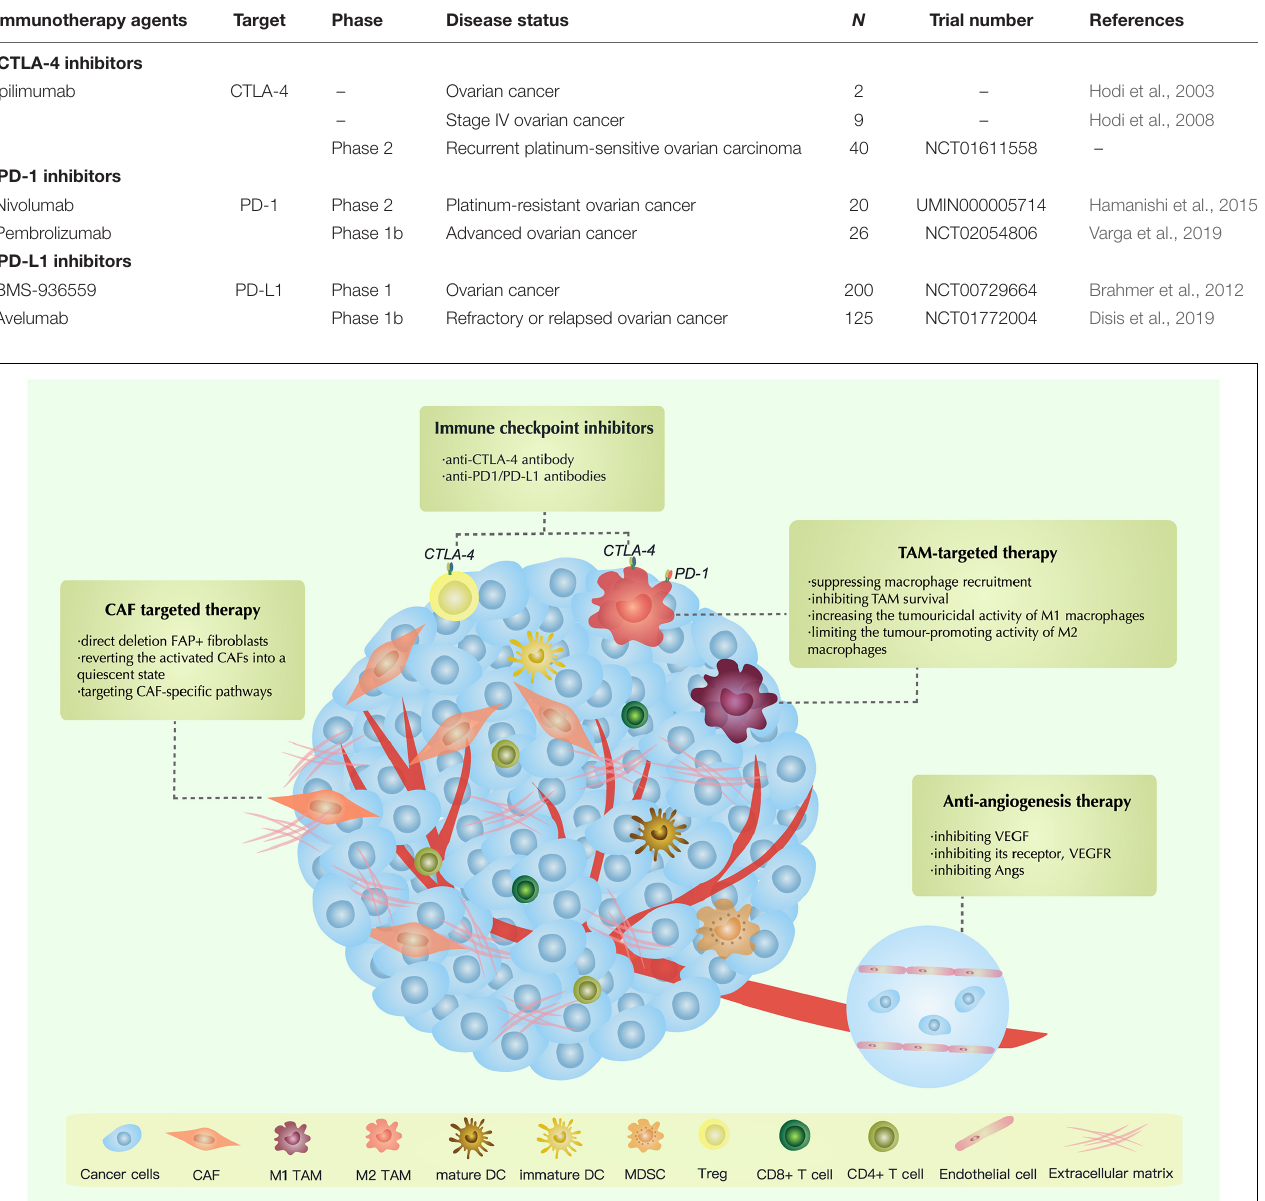
TABLE 2 | Immune checkpoint inhibitors in ovarian cancer.